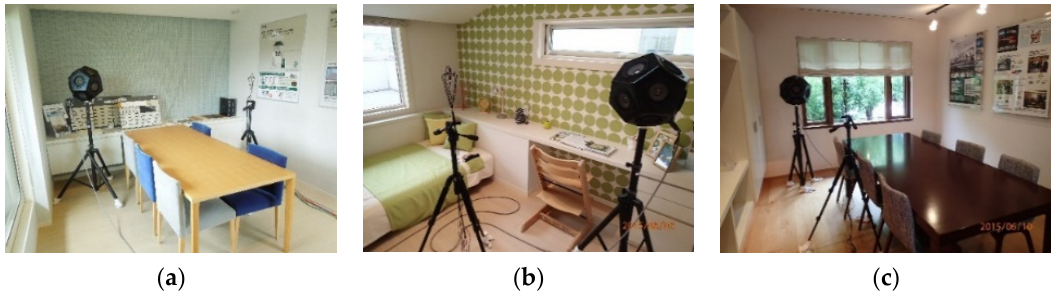
Figure 10. Measurement of impulse responses in the three child rooms: houses ( a ) A, ( b ) B, and ( c ) C.